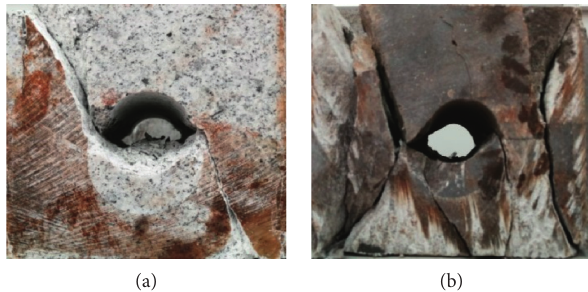
Figure 10: The overall failure of the sample: (a) marble and (b) sandstone.